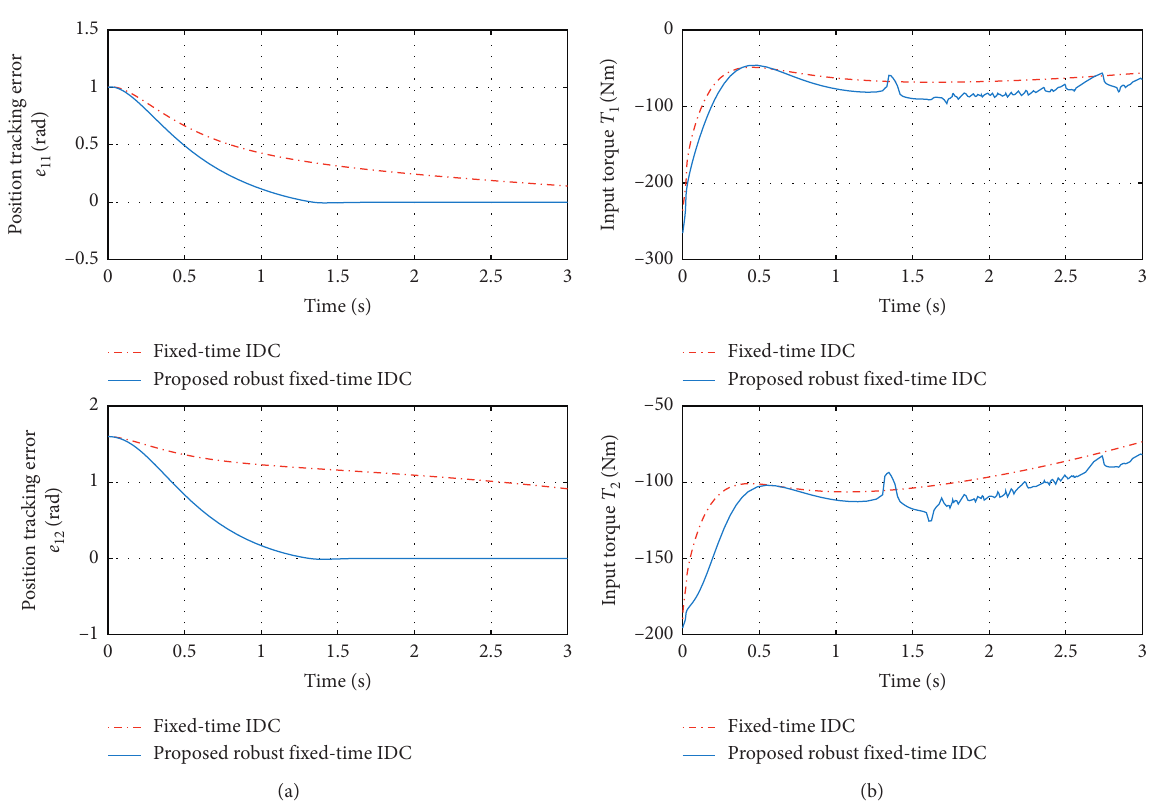
Figure 4: Responses in case 3. (a) Position tracking errors. (b) Input